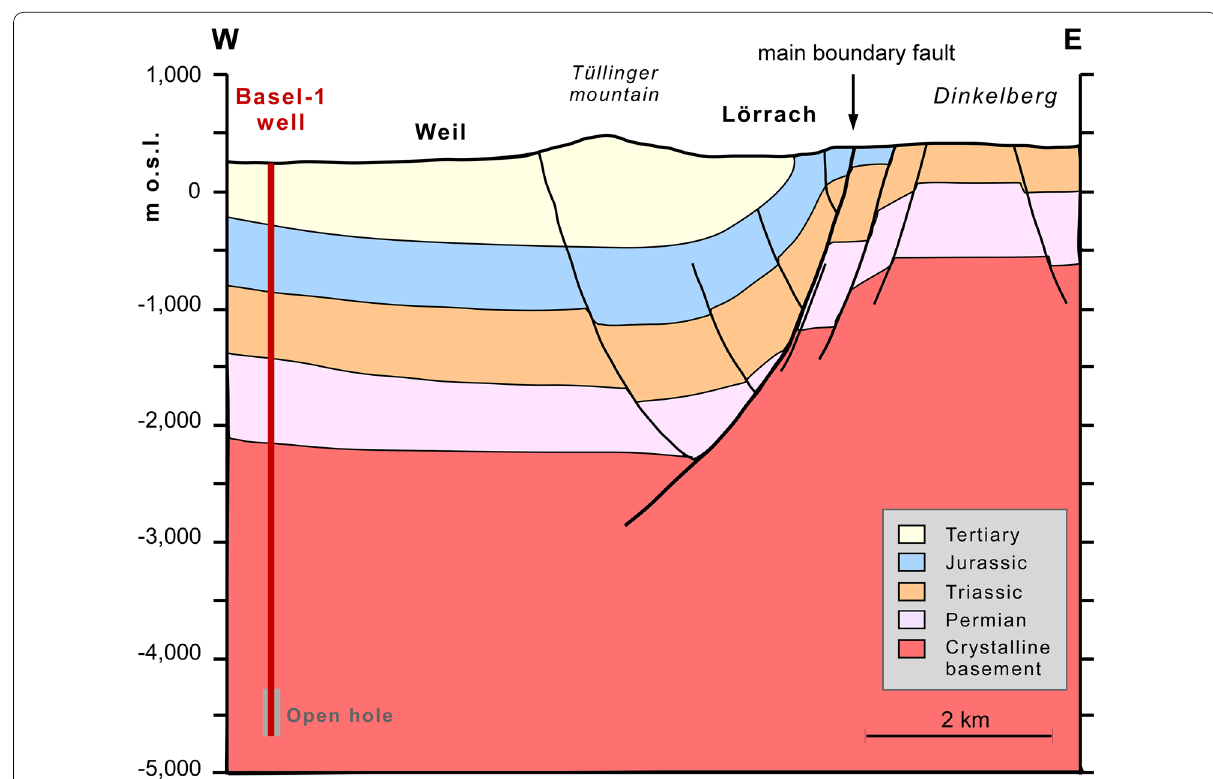
Fig. 2 WSW-ENE cross section (see Fig. 1) north of Basel, showing the sedimentary cover and tectonic situation of the